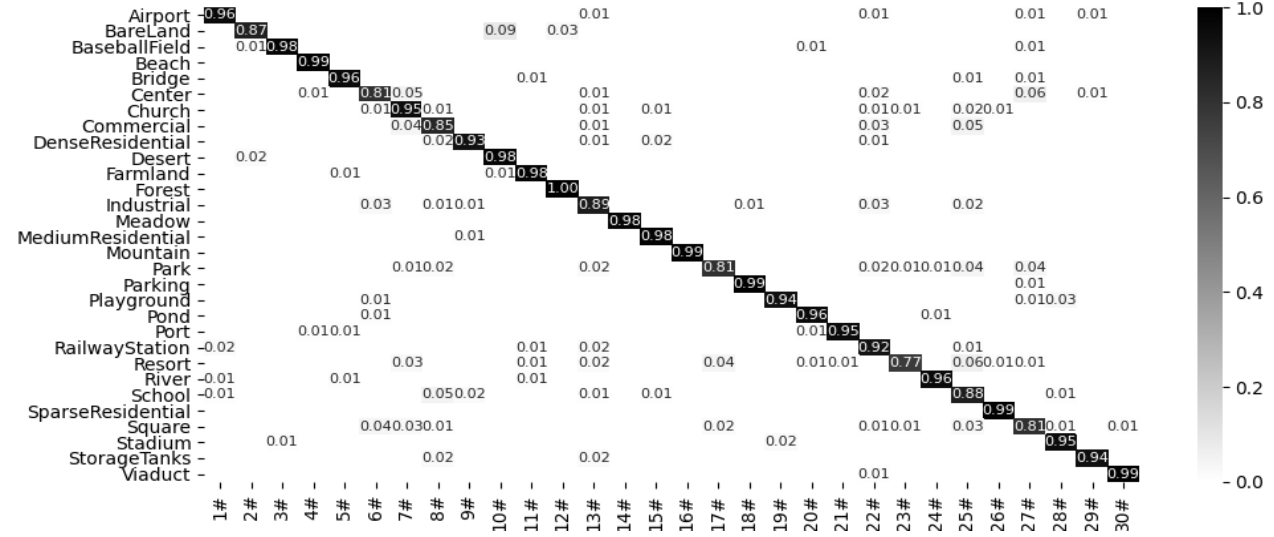
Figure 12. Confusion matrix of the proposed method on the AID30 dataset (20/80).